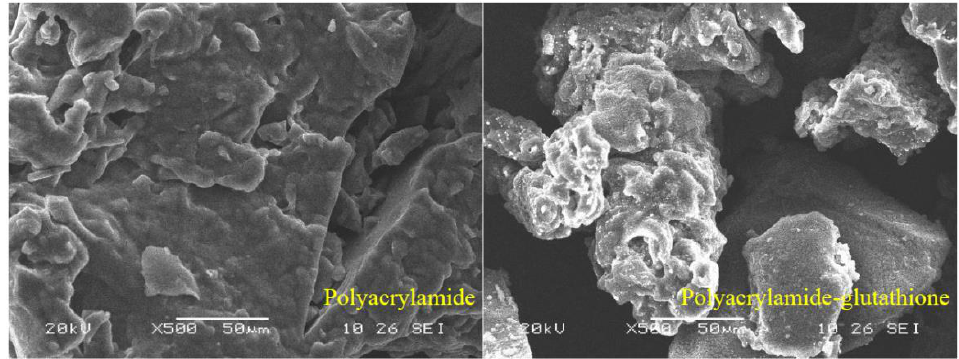
Figure 5. Comparison of before and after polyacrylamide – glutathione synthesis.